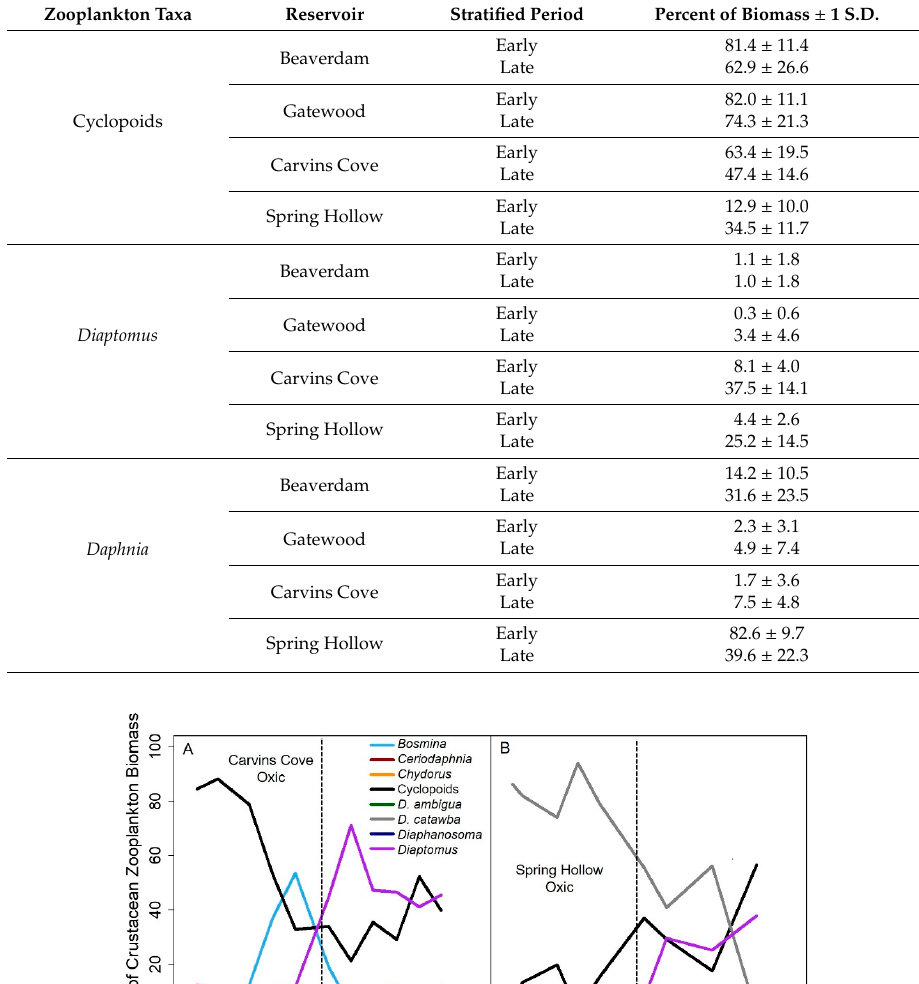
Table 4. The community composition of the three most dominant individual zooplankton taxa in the crustacean zooplankton community in the four reservoirs across years in the early vs. late stratified periods. Other zooplankton taxa comprised less than 5% of the crustacean zooplankton community across those years.